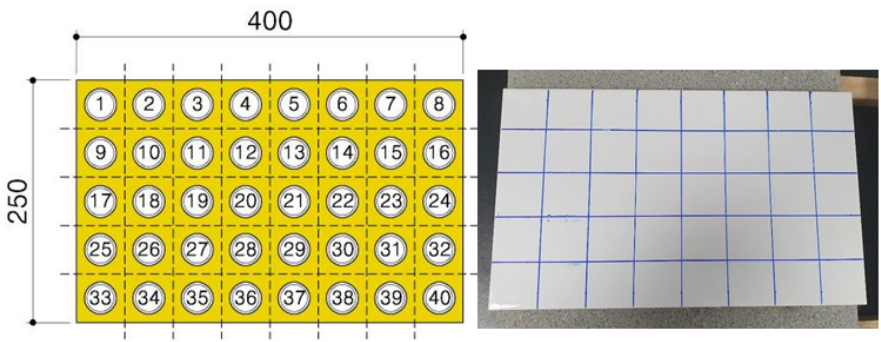
Figure 10. Tile total surface area sectioning into pieces for pull-off testing (unit: mm).